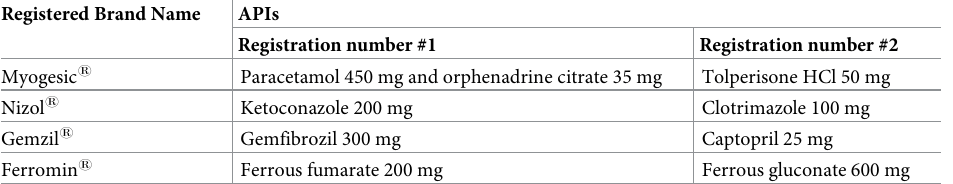
Table 1. Lists of registered brand names in single brand names from different manufacturers with diverse APIs